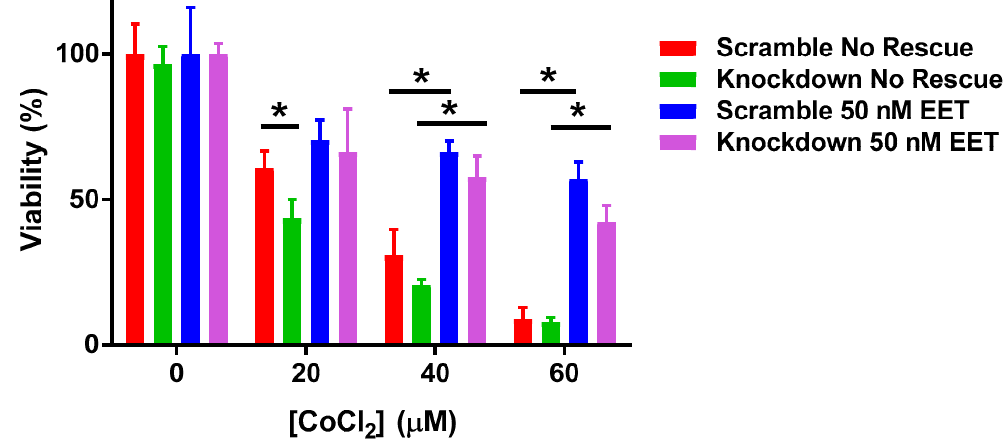
Figure 8. Cell viability in human adult-derived ventricular myocytes exposed to varying doses of CoCl 2 for 24 h, following 72 h of lipofectamine treatment with either scrambled siRNA or CYP2J2 siRNA and addition of 50 nM total EETs prior to CoCl 2 treatment. * Indicates p < 0.05.